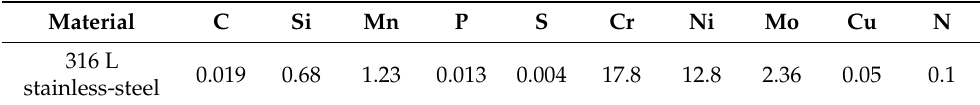
Table 1. Chemical composition of material